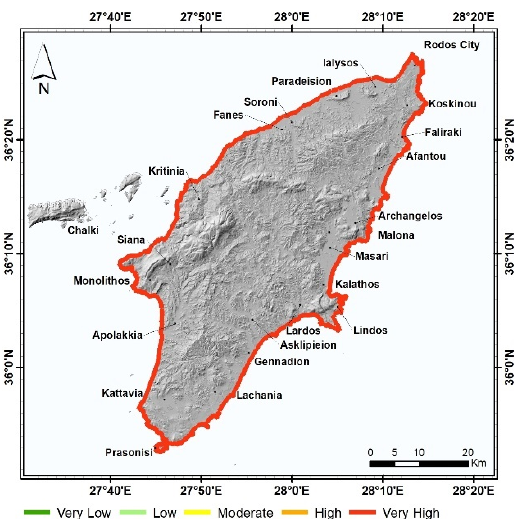
Figure 5. Evaluation of the relative coastal vulnerability due to the mean tidal range in Rhodes Island for the present and the projected to 2100 conditions.